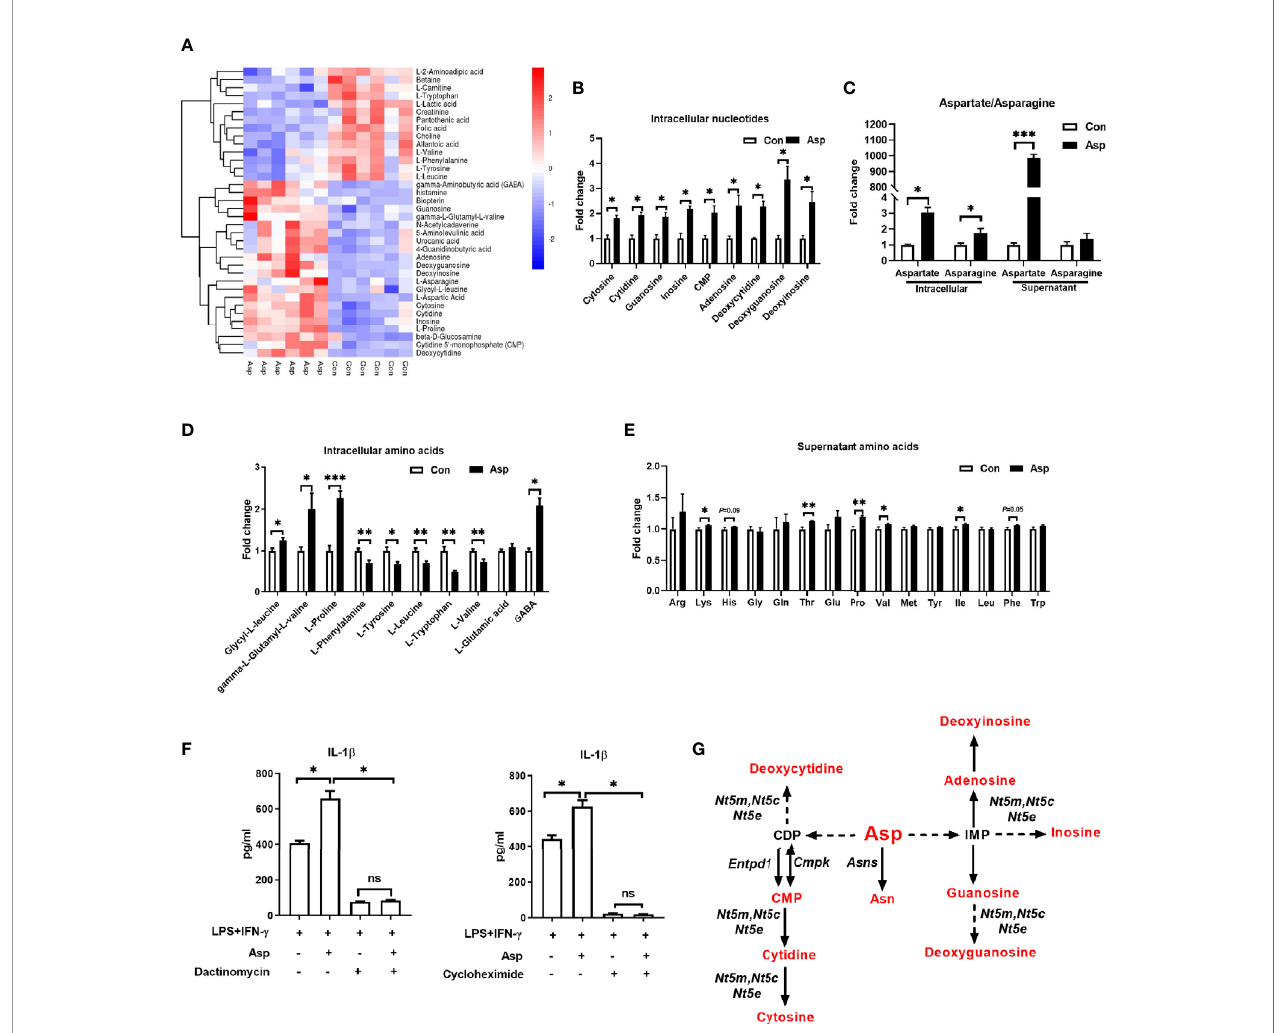
FIGURE 3 | Aspartate remodels the metabolism of macrophages. (A) Heatmap analysis of the different metabolites between M1 macrophages and aspartate- treated M1 macrophages ( n = 6). (B) Fold change of intracellular nucleotide in M1 macrophages and aspartate-treated M1 macrophages ( n = 6). (C) Fold change of the supernatant and intracellular asparagine/aspartate in M1 macrophages and aspartate-treated M1 macrophages ( n = 6). (D) Fold change of intracellular amino acids in M1 macrophages and aspartate-treated M1 macrophages ( n = 6). (E) Fold change of supernatant amino acids in M1 macrophages and aspartate-treated M1 macrophages ( n = 6). (F) Secretion of interleukin 1 b (IL-1 b ) from M1 macrophages with aspartate supplementation combined with dactinomycin or cycloheximide ( n = 3 – 4). (G) Different metabolites in aspartate metabolism between M1 macrophages and aspartate-treated M1 macrophages ( n = 6). Data were analyzed with unpaired t -test (B – E) or with one-way ANOVA (F) . Error bar s represent the mean ± SEM. ns, not signi fi cant. * p ≤ 0.05, ** p ≤ 0.01, *** p ≤